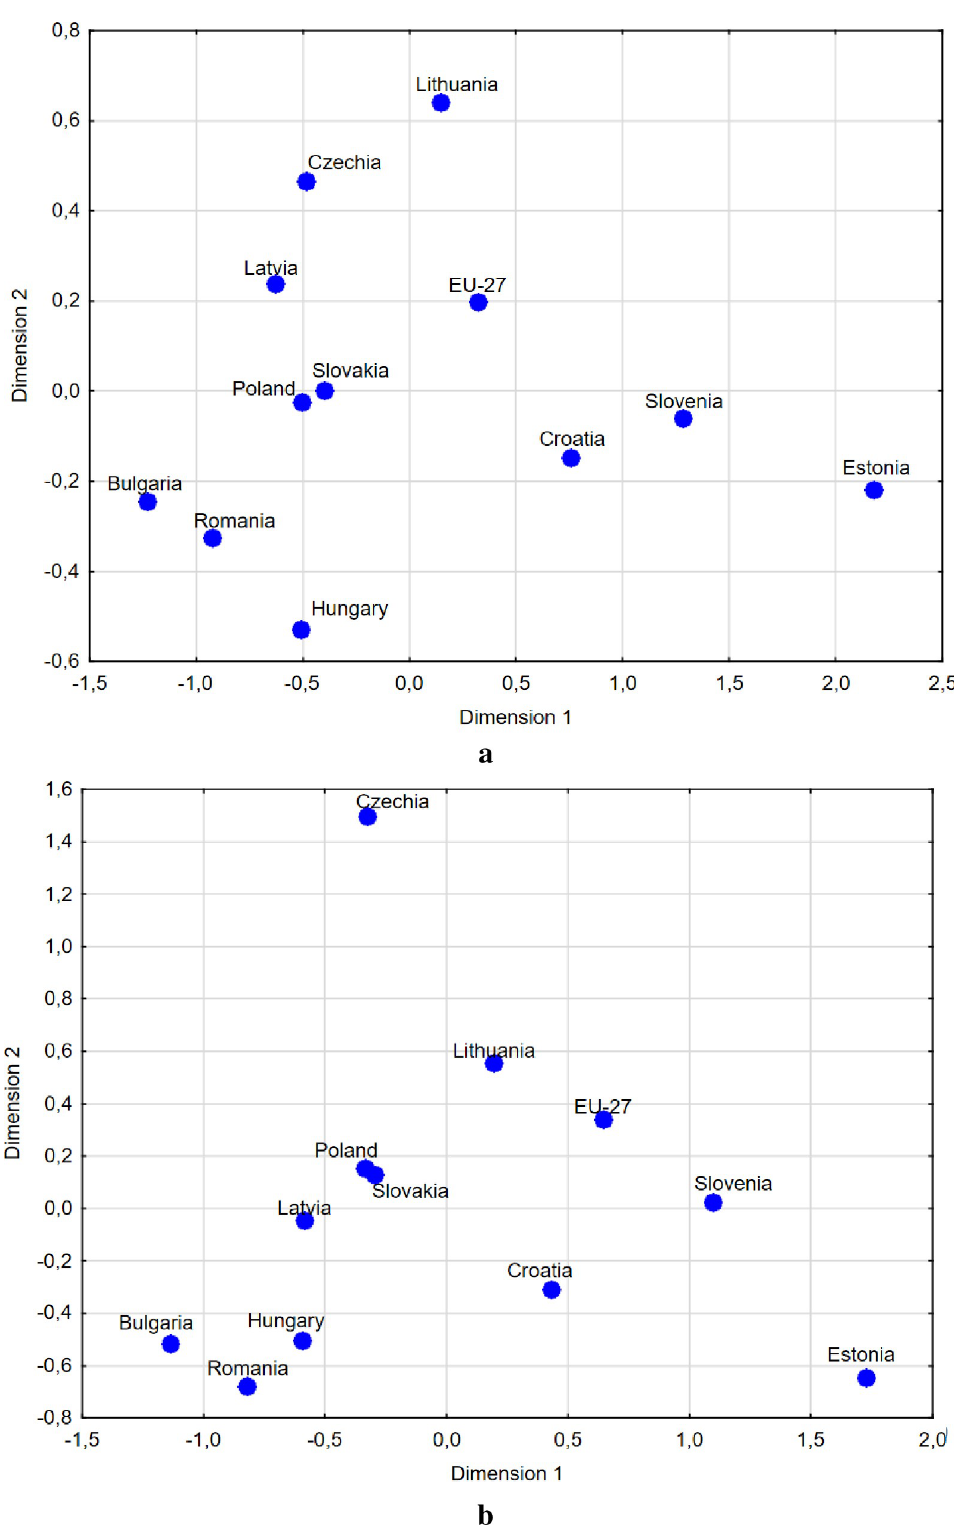
Fig 11. Similarities between the CEE countries in terms of digital maturity characterized by the set of 14 determinants in a two-dimensional space (a–all enterprises, b–manufacturing enterprises).